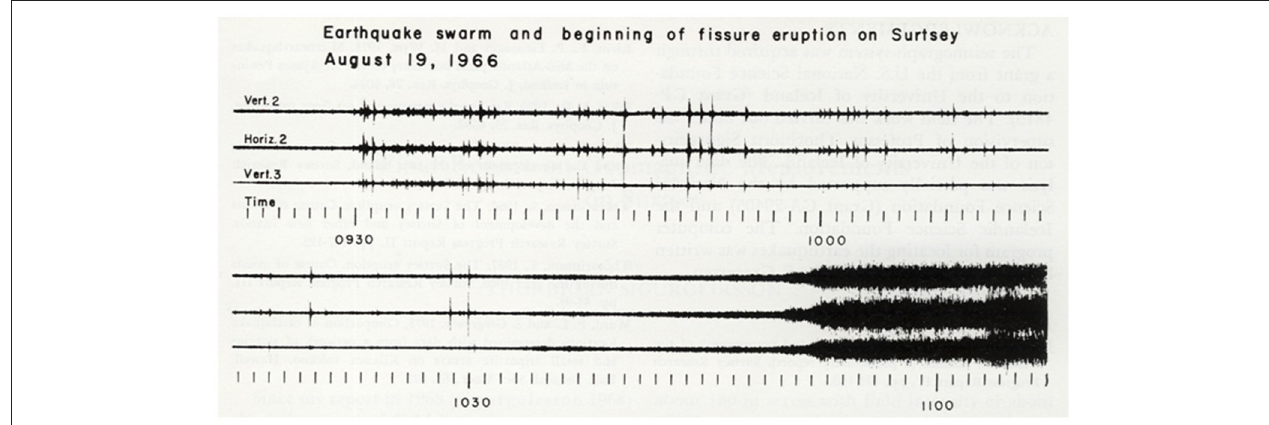
FIGURE 2 | Seismograms from three components of a small array operated on Surtsey island in 1966, showing the time interval 09:22–11:07 on August 19, when a new lava eruption broke out on the island (from Einarsson, 1974). Reproduced with the permission of the copyright holder, the Surtsey Research